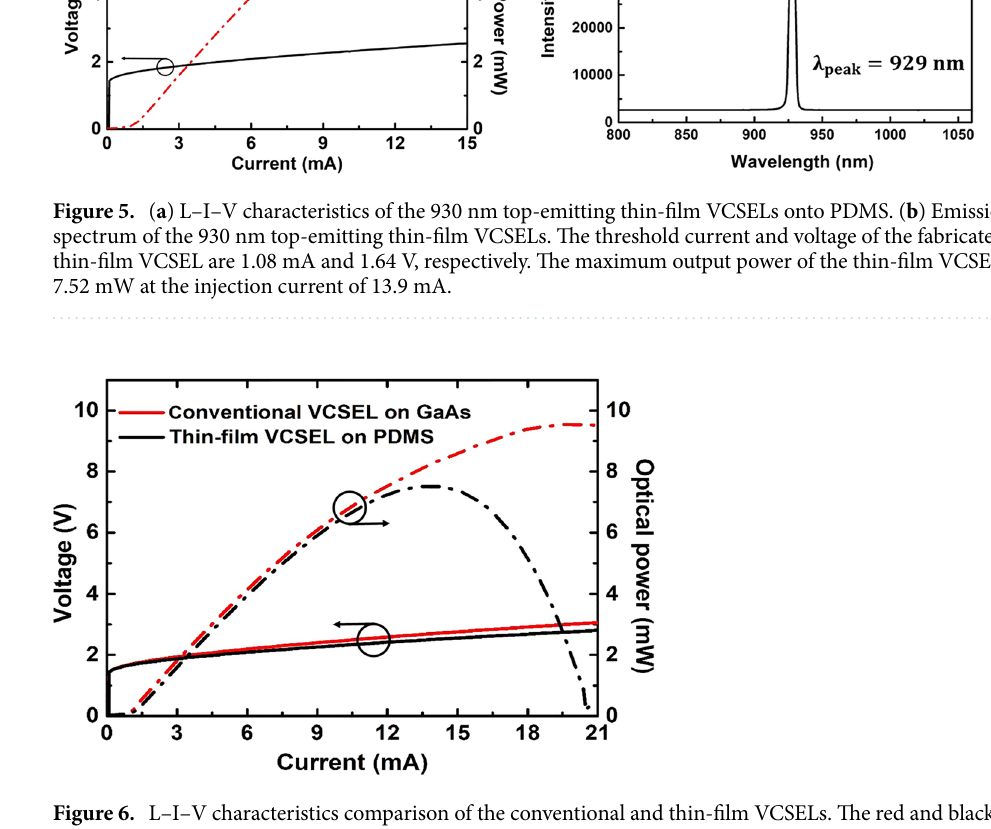
Figure 6. L–I–V characteristics comparison of the conventional and thin-film VCSELs. The red and black lines indicate the L–I–V characteristics of the conventional VCSEL and thin-film VCSEL mounted on PDMS, respectively. The threshold current and maximum output power of the conventional VCSEL are 1.09 mA and 9.57 mW at an injection current of 19.8 mA, respectively, while those for the thin-film VCSEL are 1.08 mA